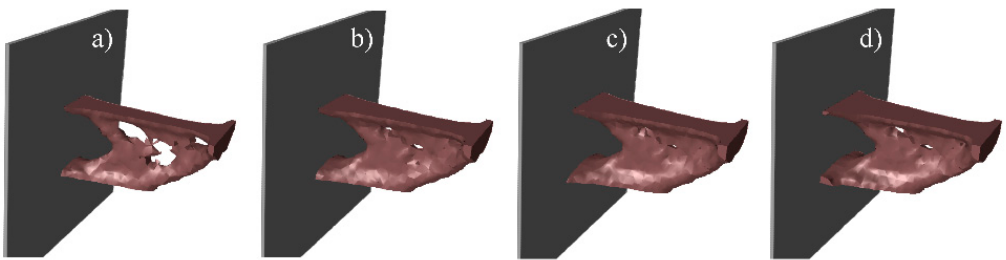
Figure 12. Representation of beams for experiment OT3with an FOS equal to ( a ) 1, ( b ) 1.25, ( c ) 1.75 and ( d ) 2.